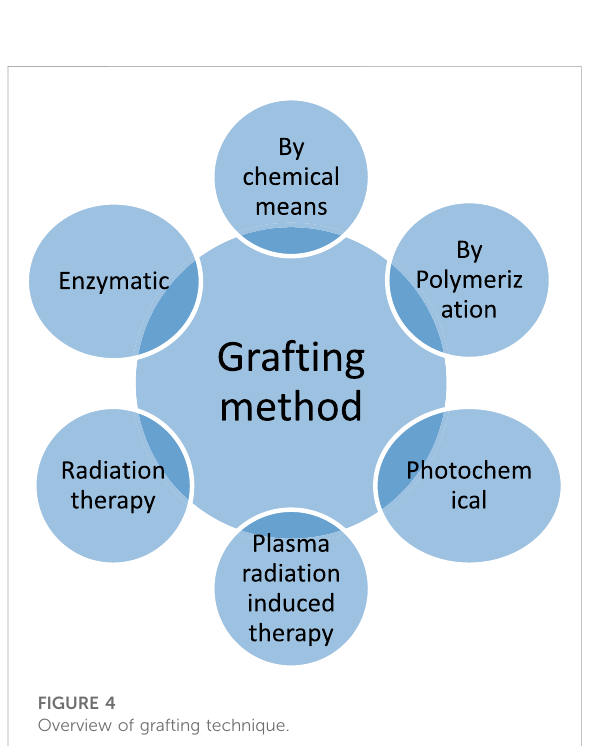
FIGURE 4 Overview of grafting